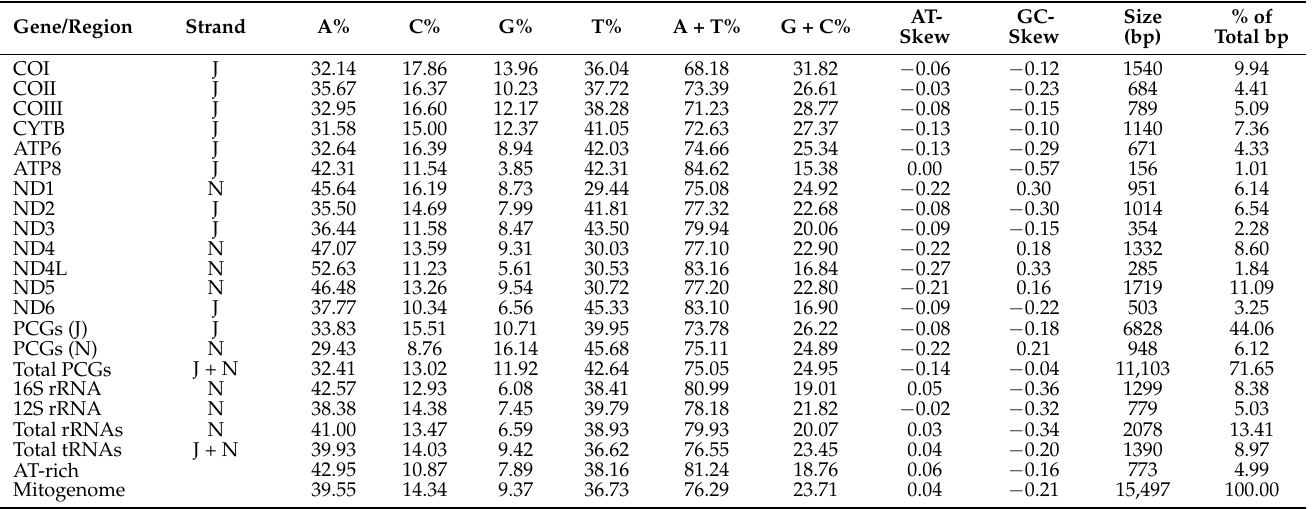
Table 3. Nucleotide composition of the complete mitochondrial sequence of the Olive Seed Weevil, Anchonocranus oleae . AT-skew = (A − T)/(A + T); CG-skew = (G − C)/(G + C).